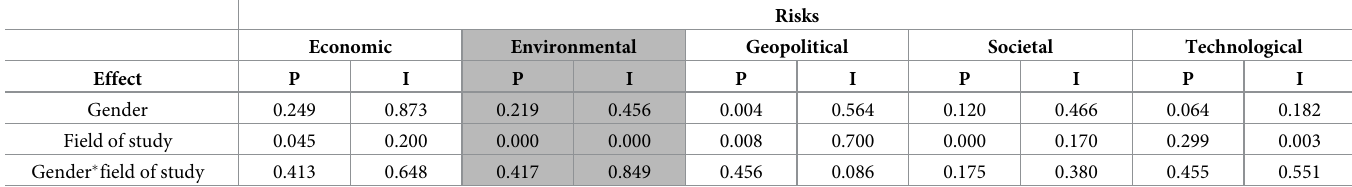
Table 2. Results of the two-way ANOVA analysis for the probability (P) and the impact (I) for each type of risk for p <